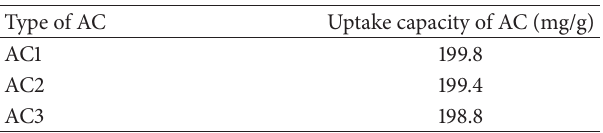
Table 2: Adsorption capacity for the synthesized AC by MB adsorption.